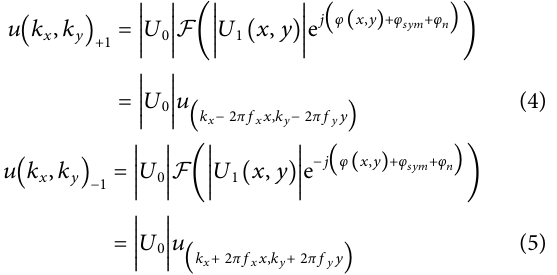
Frontiers in Physics |